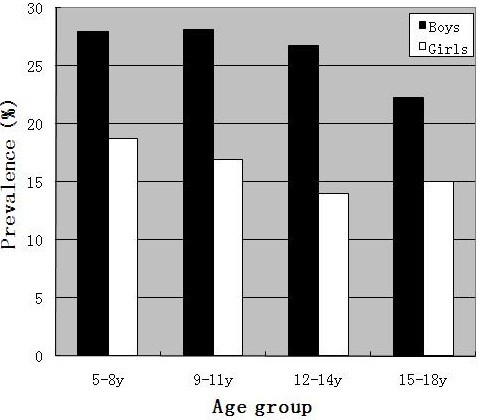
Prevalence of overweight and obesity by age and gender.